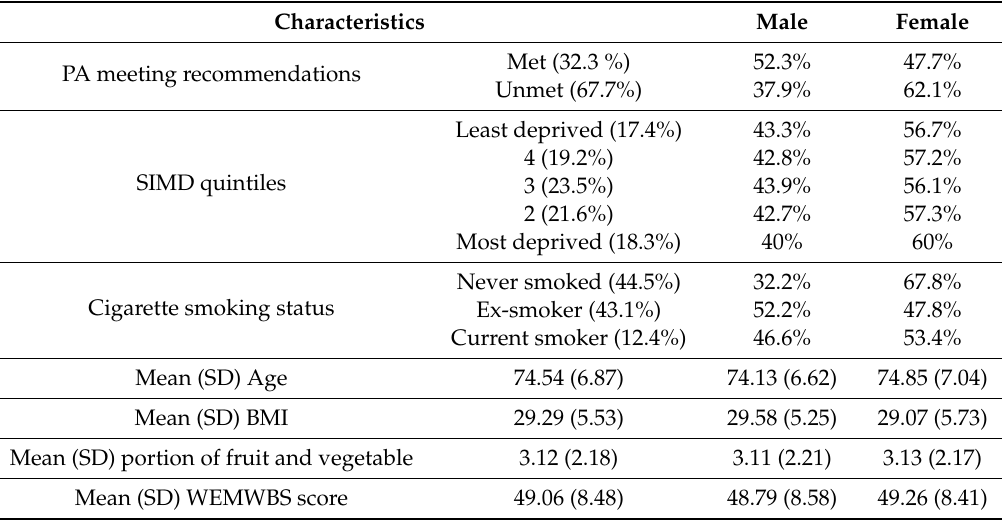
Table 2. Demographics and health states of older adults with